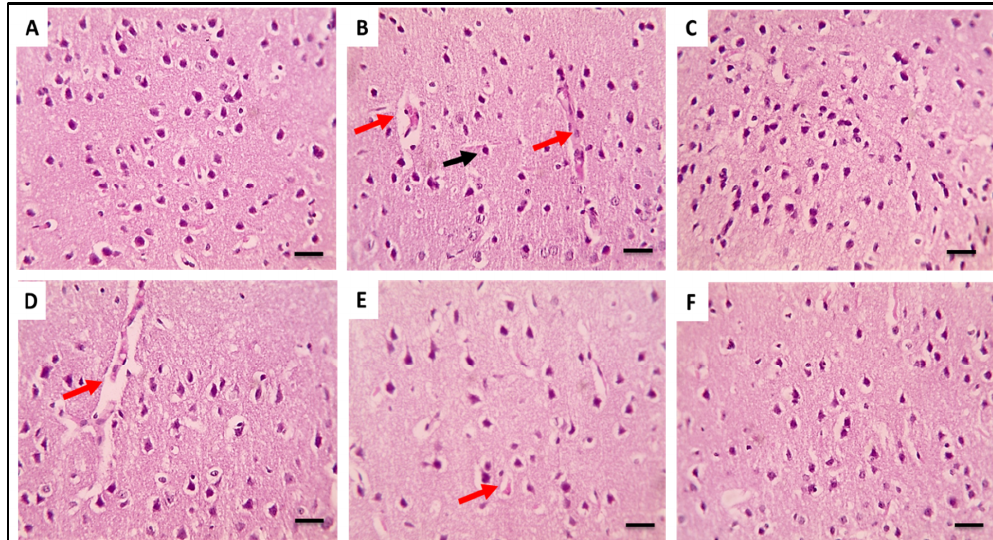
Figure 10. H&E-stained brain sections showing the cerebral cortices of the different groups. Normal neurons were revealed in the control group (group 1, ( A )). Sections from the group that received LPS (group 3, ( B )) revealed congested blood vessels (red arrows) and the shrinkage of neurons (black arrows). Sections from the treated group with RVS (group 4, ( C )) showed normal neurons. Sections from the treated group with SPE 100 mg/kg (group 5, ( D )) showed normal neurons with congested blood vessels (red arrow). Sections from the treated group with SPE 200 mg/kg (group 6, ( E )) showed normal neurons with mildly congested blood vessels (red arrow). Sections from the treated group with SPE 300 mg/kg (group 7, ( F )) showed normal neurons (×400).